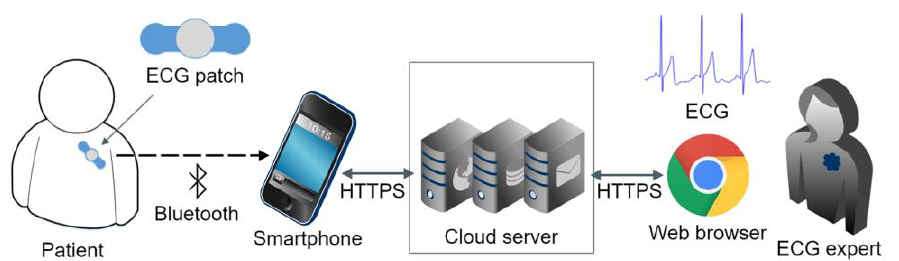
Figure 1. Illustration of the wearable ECG telemonitoring system.